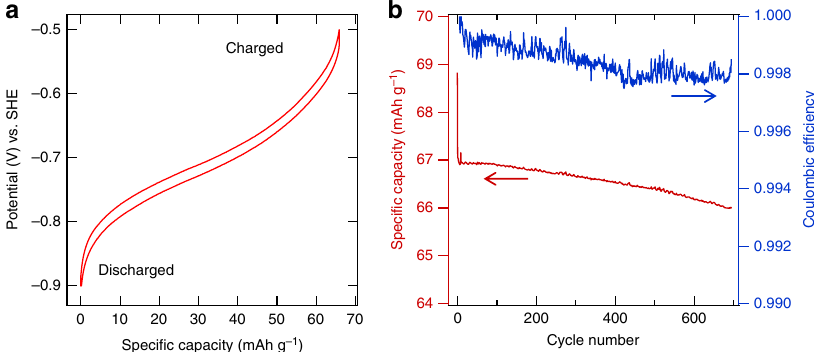
Fig. 2 Half-cell electrochemical characterization of MnHCMn vs. SHE. a The reaction potential pro fi le of the MnHCMn electrode vs. SHE at a 1C rate. Electrolyte is 1 M NaClO 4 , 90% MeCN, 10% water. b The cycle life and coulombic ef fi ciency of the MnHCMn electrode during 1C – 1C cycling between – 0.5 and – MnHCMn(II/I) anode have an average cell voltage of 1.55 V,